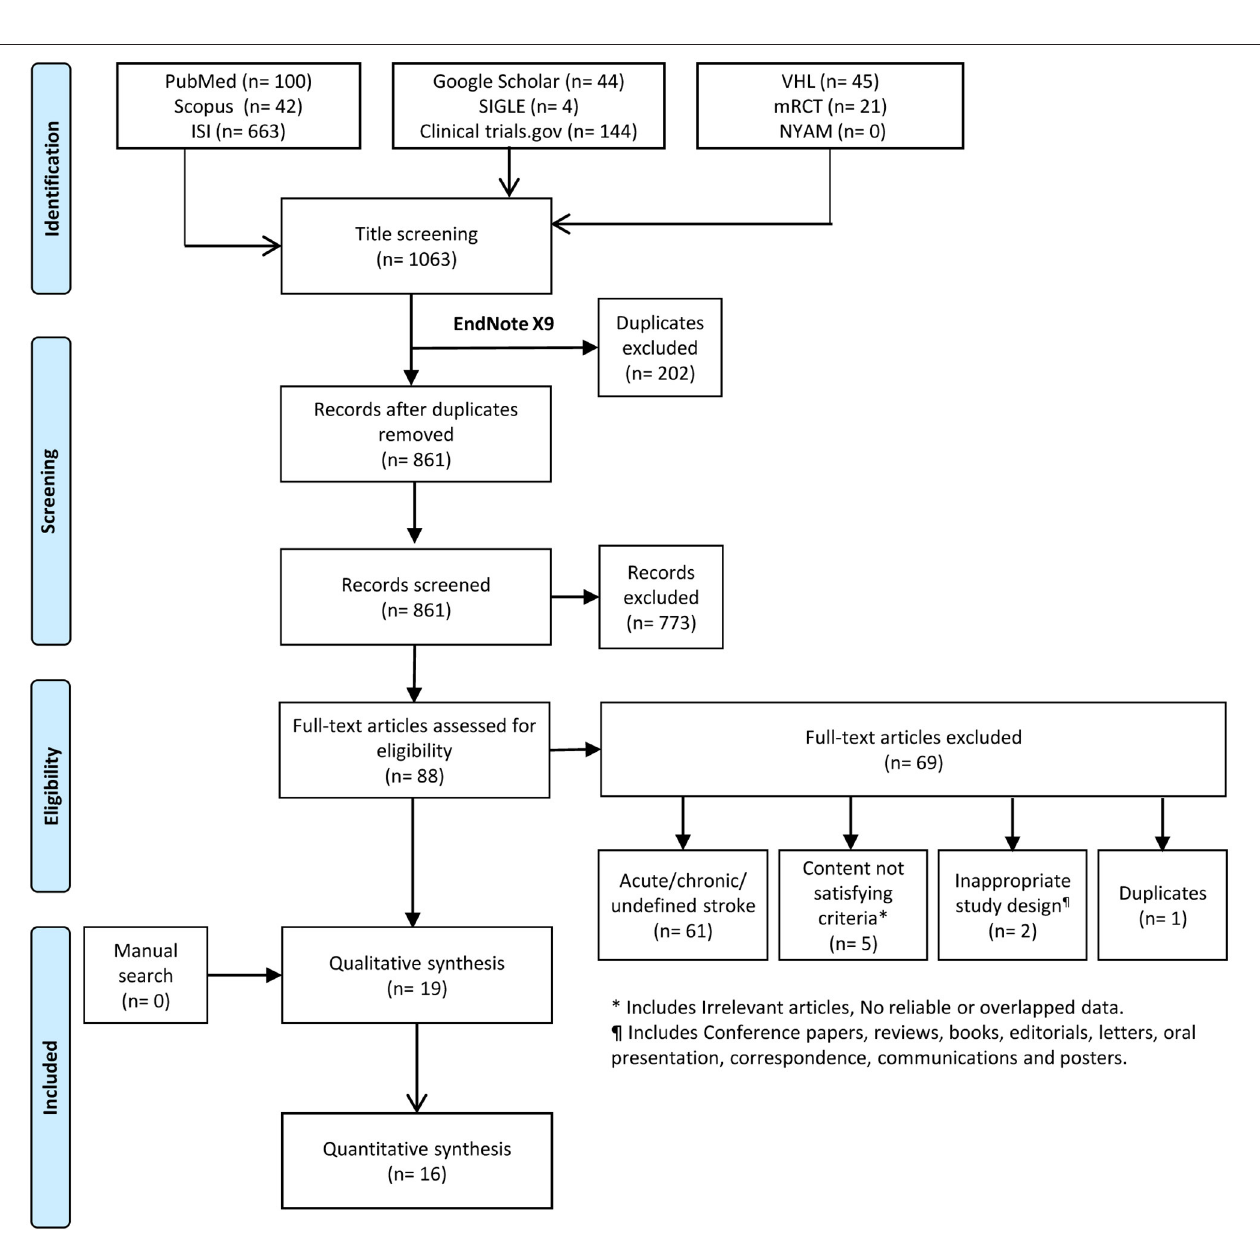
FIGURE 1 | PRISMA flow diagram showing the process of the